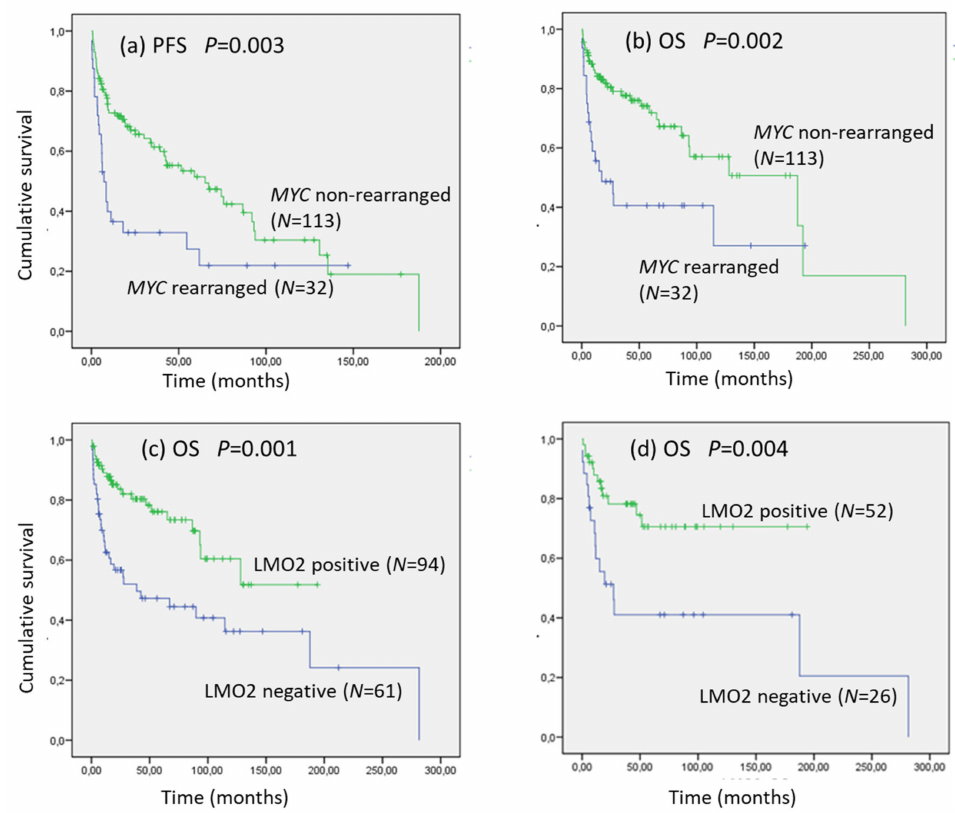
Figure 1. Progression-free survival (PFS) ( a ) and overall survival (OS) ( b ) of MYC rearrangements in 155 LBCL. OS of LMO2 expression in 155 LBCL ( c ) and 78 CD10-positive LBCL ( d